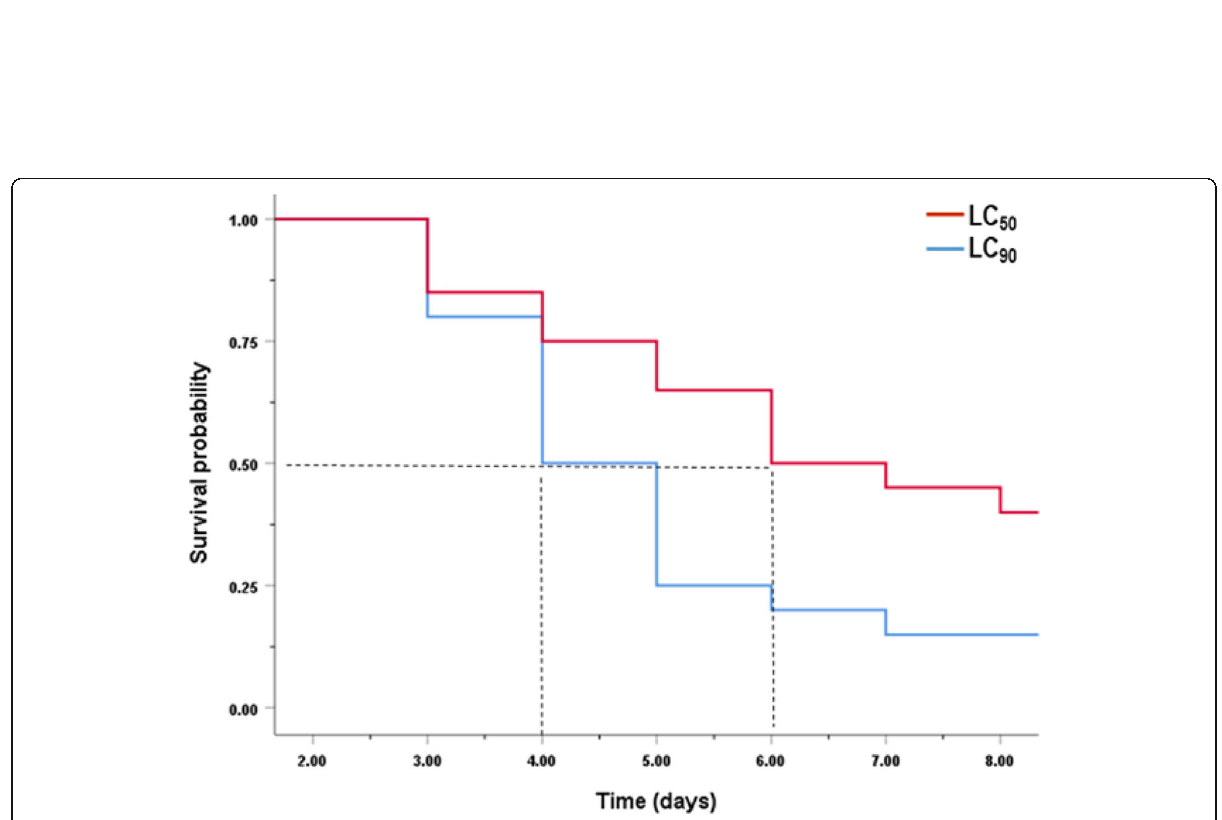
Fig. 3 Survival function of Helicoverpa armigera larvae at different occlusion body (OB)